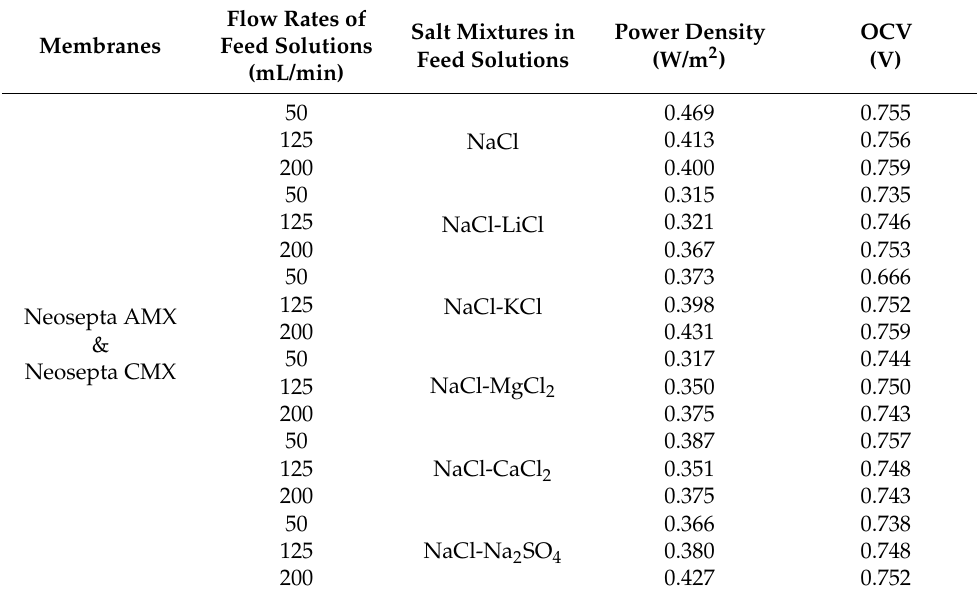
Table 7. Power density and OCV results of the studies performed by Neosepta AMX and Neosepta CMX membranes. Flow Rates of Salt Mixtures in Membranes Feed Solutions Feed (mL/min)